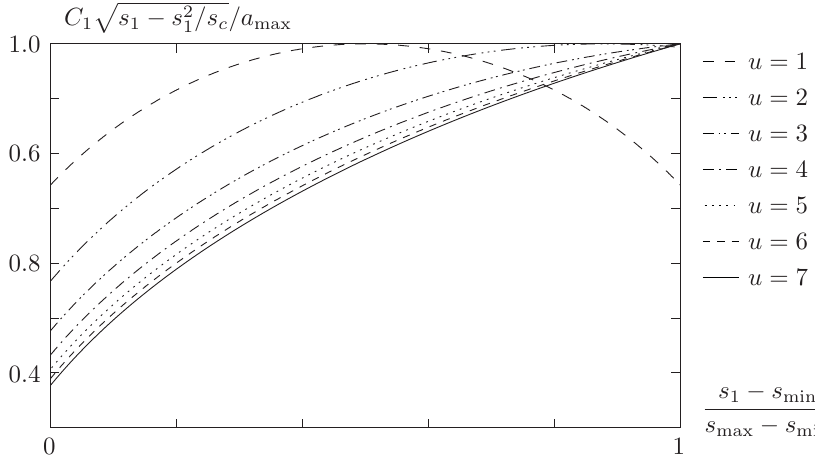
Figure 5: Normalized variation in the contact zone half-width for different gear ratios ranging from u = 7 to u = 1, the load is assumed constant along the contact line. The plot is made for a pinion gear with n z = 17, β = π/ 9 and α = π/ 9.